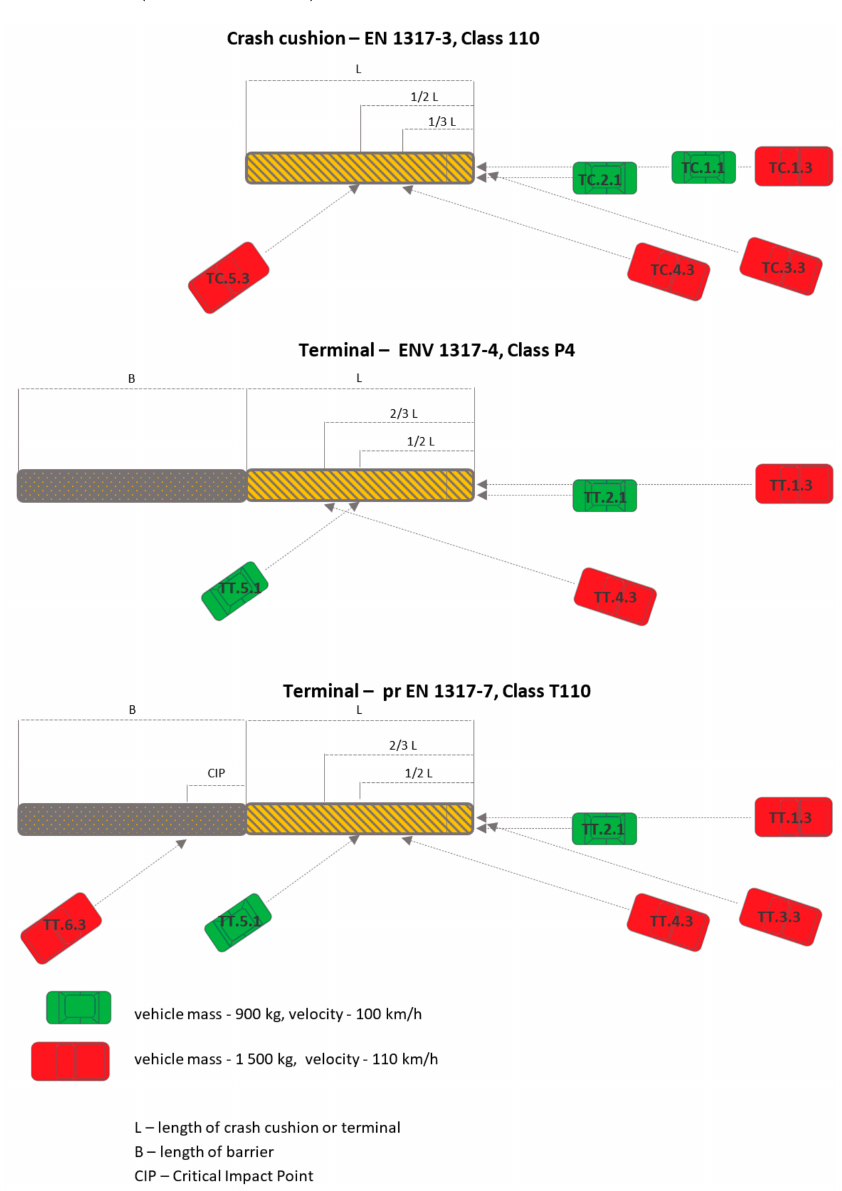
Figure 4. Crash tests for crash cushions and terminals according to standards EN 1317-3, ENV 1317-4, pr EN